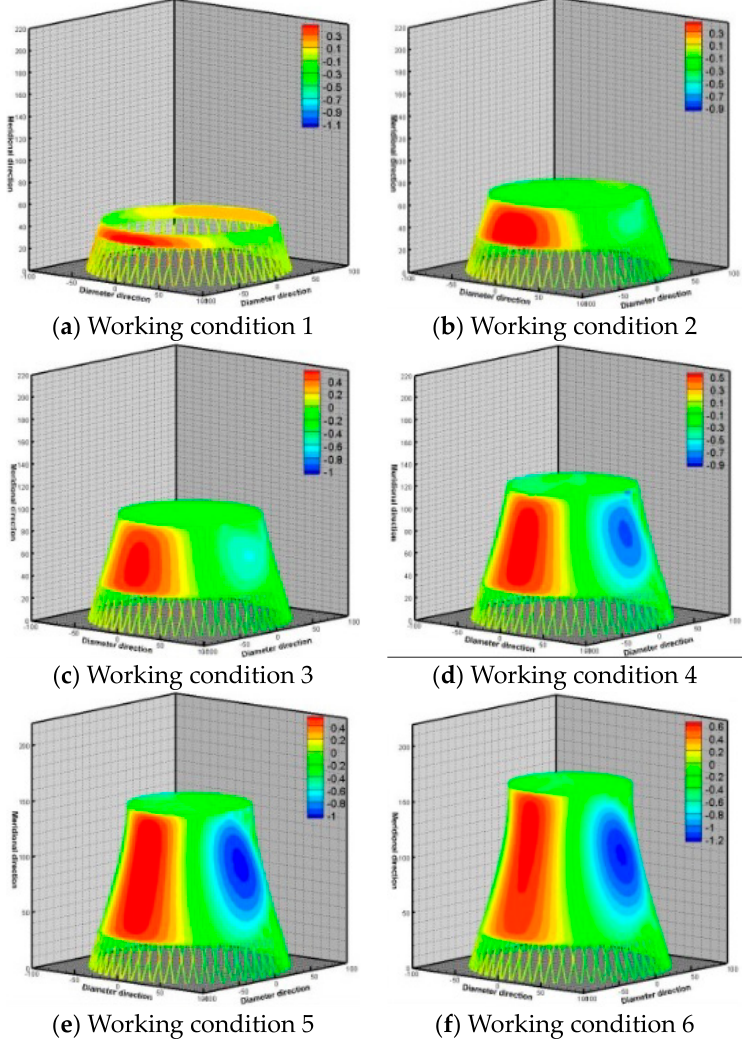
Figure 4. Power spectral density curves of pulsating wind pressure at the representative measuring points.